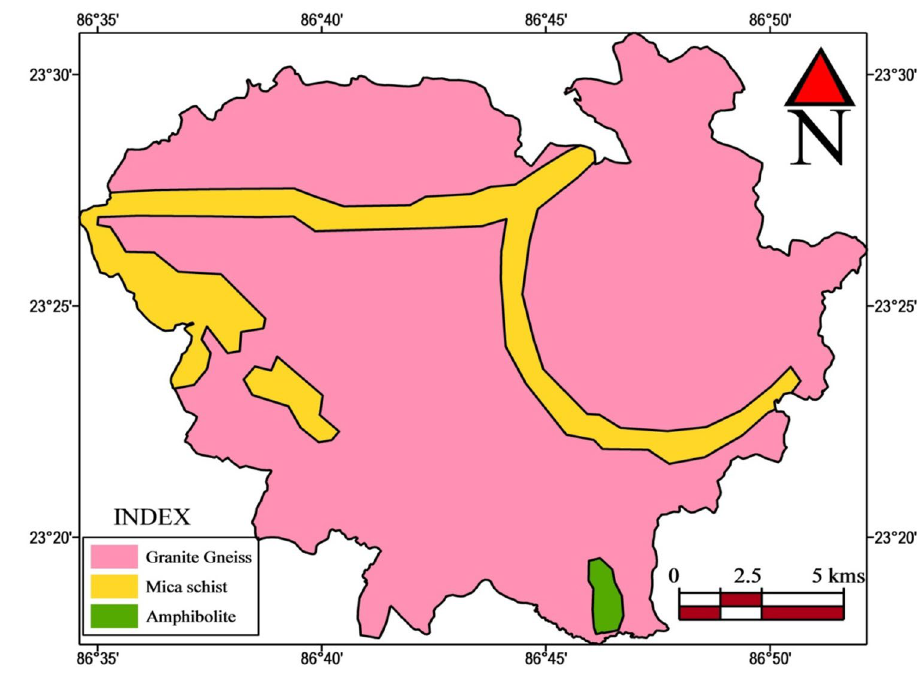
Fig. 2 Geological map of the study area